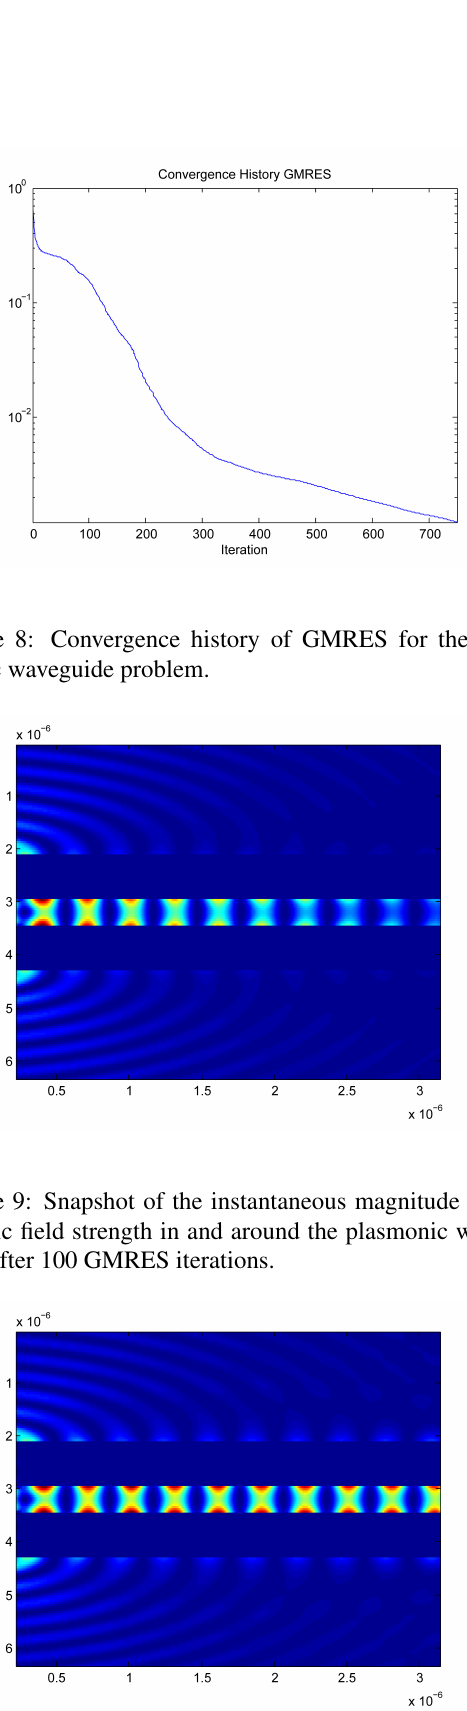
Figure 10: Snapshot of the instantaneous magnitude of the electric field strength in and around the plasmonic waveg- uide after 500 GMRES